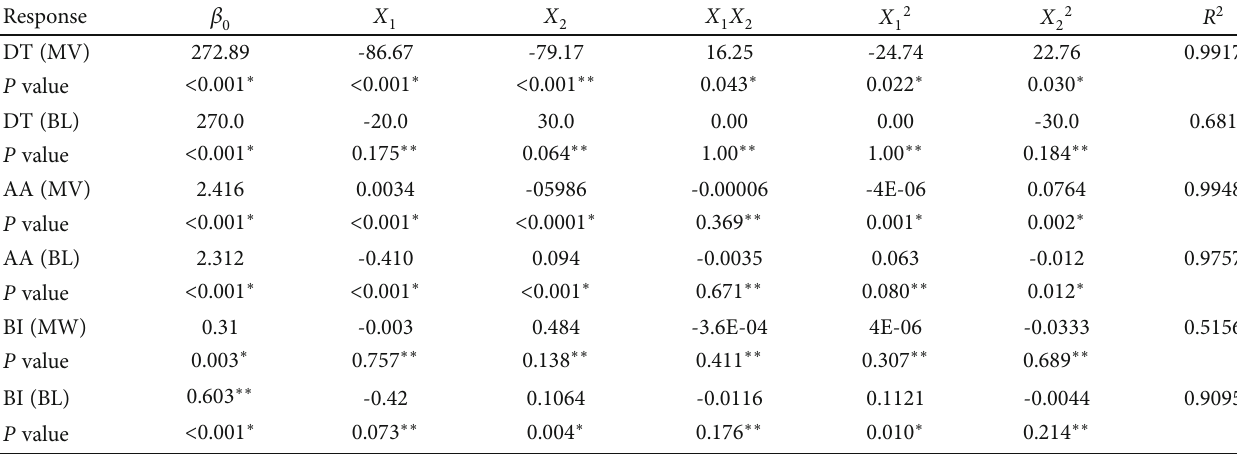
Table 6: Model terms, coe ffi cients, and statistical signi fi cance for microwave- and blanching-assisted drying on DT, AA, and BI.